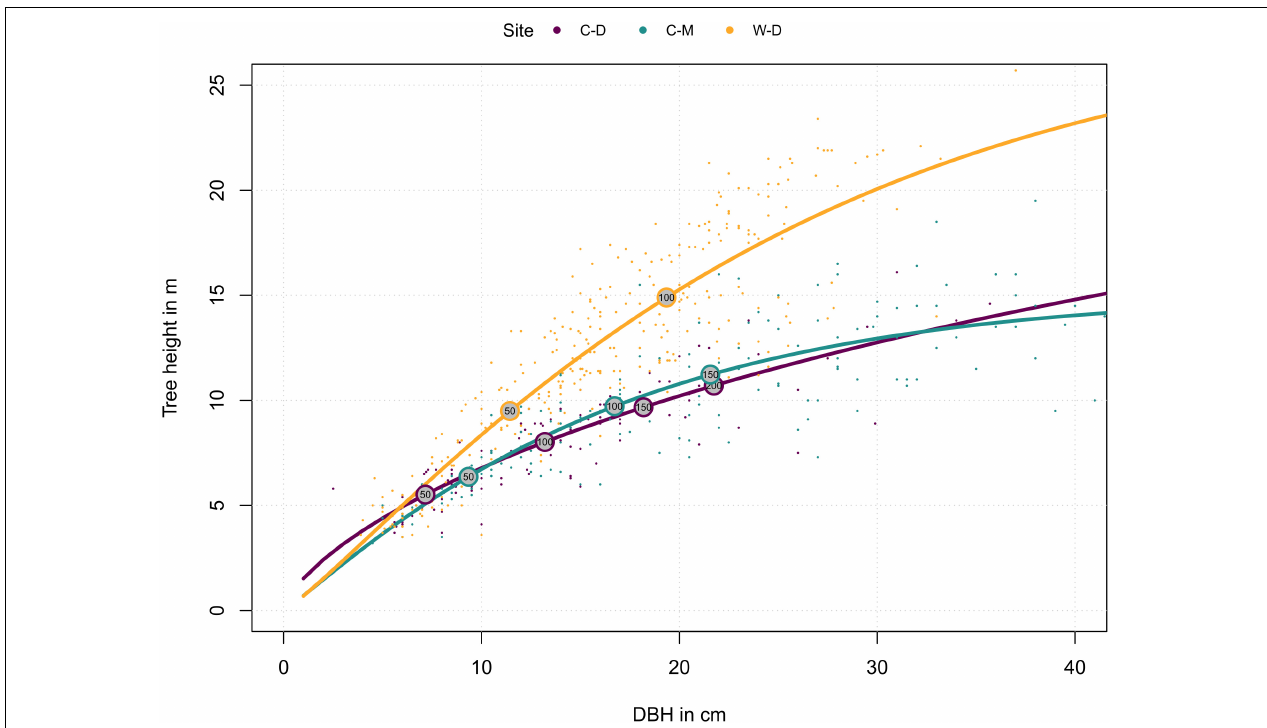
FIGURE 2 | Relationship of site-specific diameter at breast height (DBH) and tree height. Dots represent individual trees. Lines represent the site-specific means as described by the functions in the methods (Eqs. 1 and 2). Numbers in the circles indicate tree age. Purple = Brooks Range (C-D), Green = Denali National Park (C-M), Orange = Bluff (W-D).